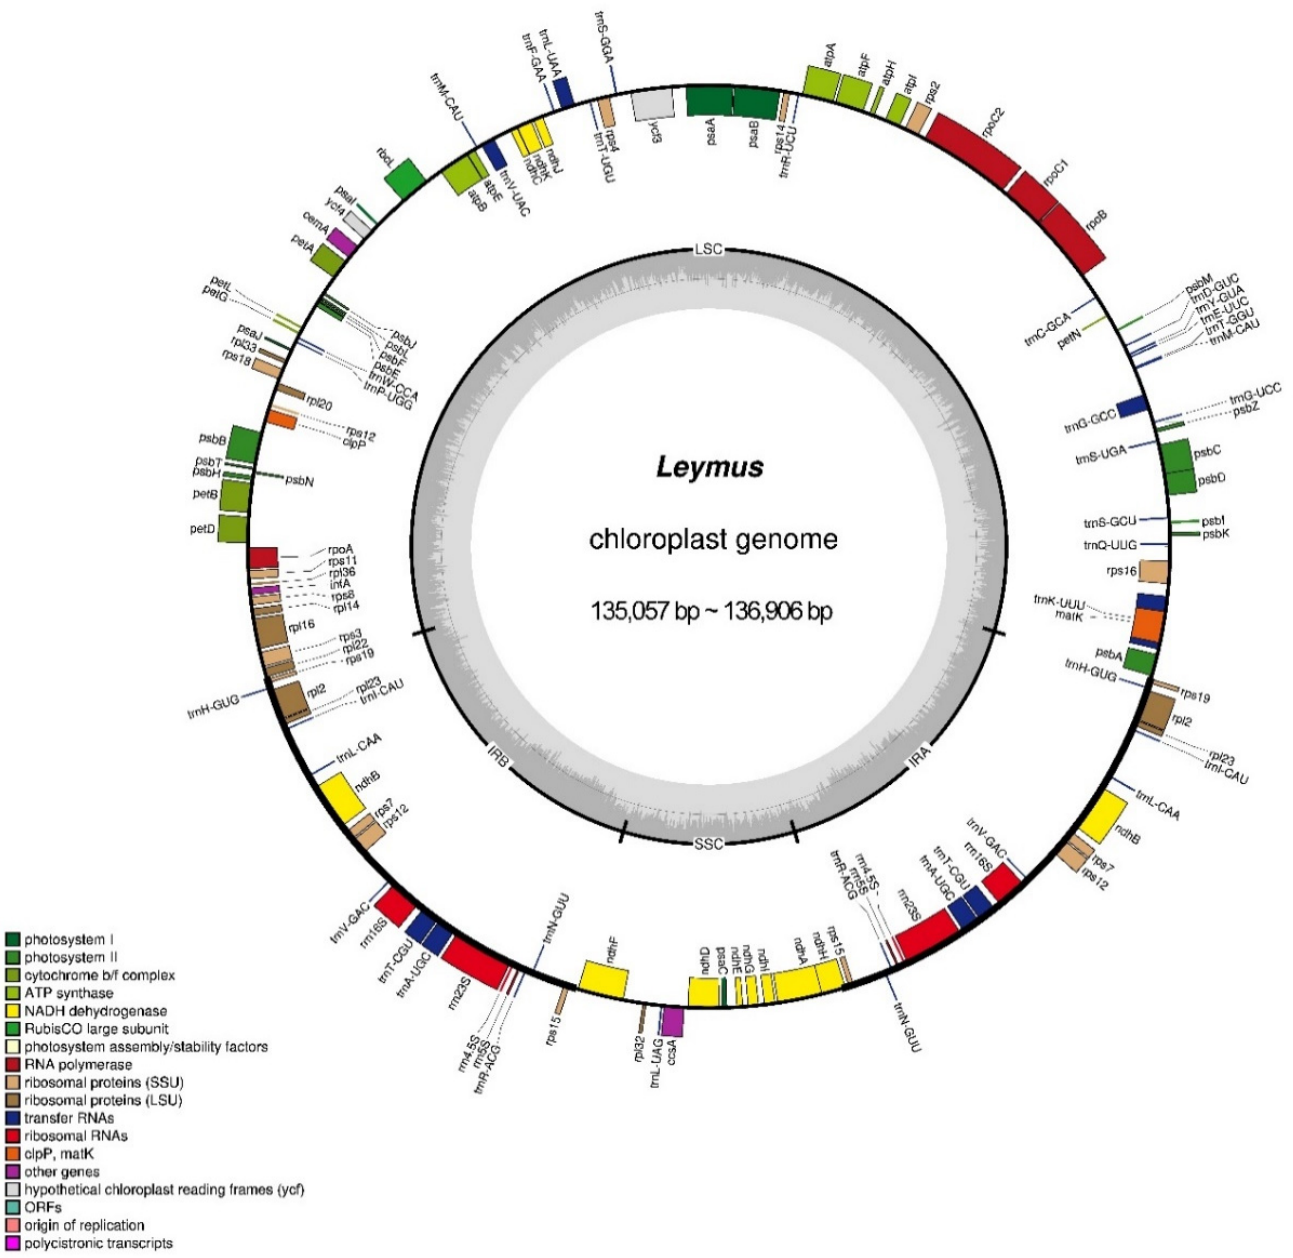
Figure 1. Chloroplast (cp) genome map of Leymus species with L. chinensis as reference. The inner circle shows the GC and AT content. LSC, SSC, and IR (IRa and IRb) represent the large single copy, small single copy, and inverted repeats, respectively. Genes inside of the large circle are transcribed clockwise and those outside are transcribed counterclockwise. Genes with different functions are shown in different color blocks. Table 1. Number of SSRs in the chloroplast genomes of 16 Leymus species.